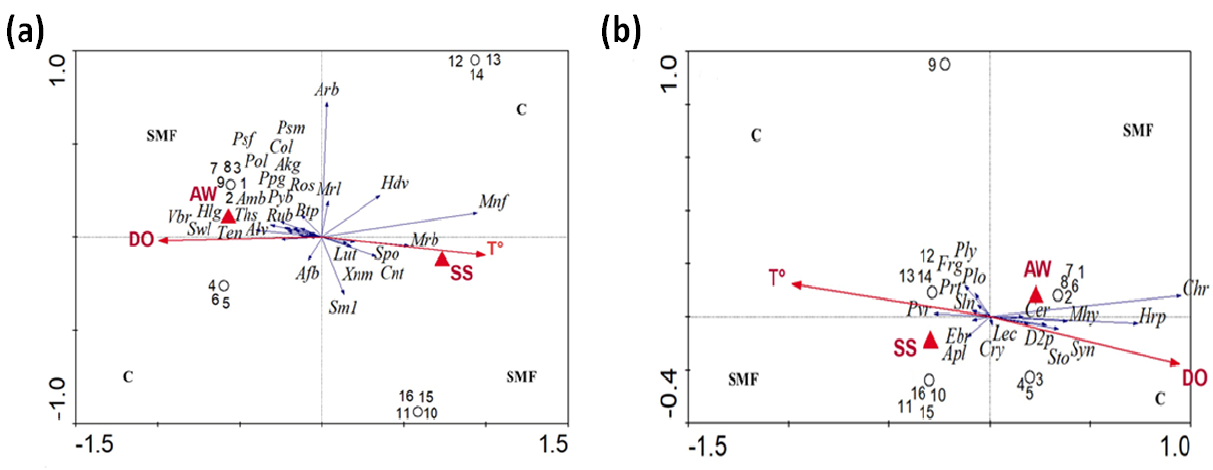
Figure 8. Canonical Redundancy Analysis (RDA) conducted for bacteria ( a ) and eukaryotes ( b ), according to the environmental conditions (i.e., temperature and dissolved oxygen concentration), and OTU abundance during Autumn–Winter (A–W) and Spring–Summer (S–S) survey periods under both static magnetic field (SMF) perturbations and control (C). OTUs bacteria ( a ): Aliivibrio (Alv), Aliikangiella (Akg), Amylibacter (Amb), Arcobacter (Arb), Arcticiflavibacter (Afb), Blastopirellula (Btp), Candidatus_tenderia (Cnt), Colwellia (col), Halioglobus (Hlg), Halodesulfovibrio (Hdv), Lutimonas (Lut), Marinicella (Mrl), Marinifilum (Mnf), Marinobacter (Mrb), Polaribacter _4 (Pol), Propionigenium (Ppg), Pseudoalteromonas (Psm), Pseudofulvibacter (Psf), Psychrilyobacter (Pyb), Roseibacillus (Ros), Rubripirellula (Rub), Shewanella (Swl), SM1A02 (Sm1), Spongiibacterium (Spo), Tenacibaculum (Ten), Thalassotalea (Ths), Vibrio (Vbr), Xanthomarina (Xnm). OTUS eukaryotes ( b ): Aplanochytrium (Apl), Cercozoa (Cer), Chromadorida (Chr), Cryothecomonas (Cry), D2P04A09 (D2p), Ebria (Ebr), Fragilidium (Frg), Harpacticoida (Hrp), Lecudina (Lec), Monhysterida (Mhy), Parvilucifera (Pvr), Ploimida (Plo), Polykrikos (Ply), Protoperidinium (Prt), Selenidium (Sln), Stolidobranchia (Sto), Syndiniales (Syn). DO, dissolved oxygen; T, temperature.